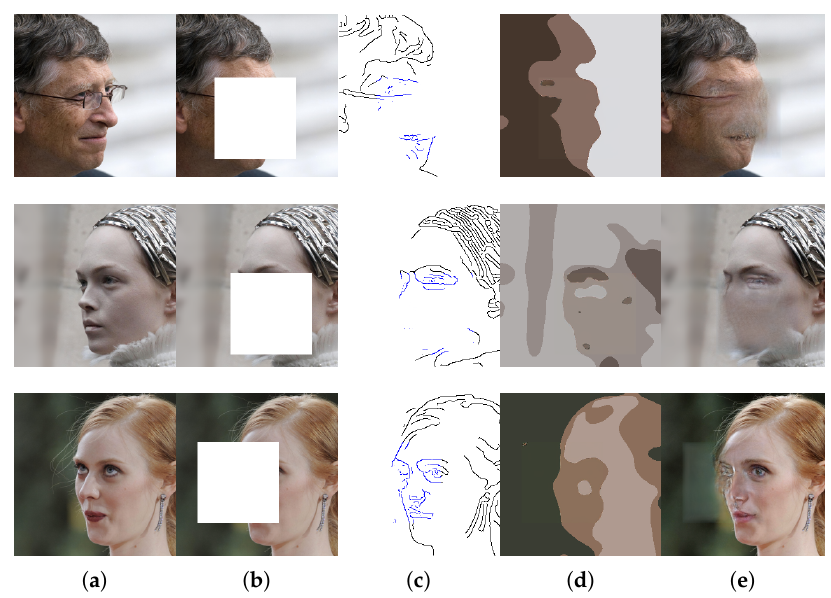
Figure 11. Failure cases of PIC-EC. ( a ) ground truth images; ( b ) masked images; ( c ) generated edge maps; ( d ) generated color maps; ( e ) completion